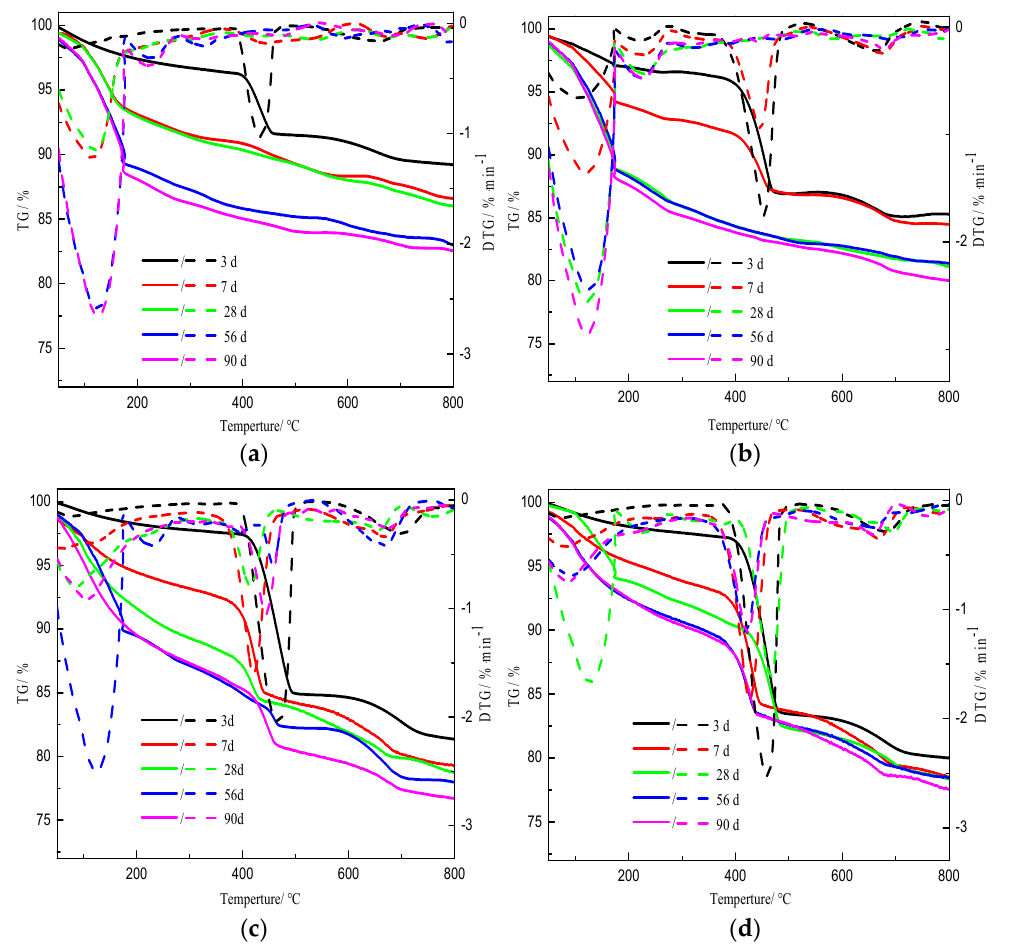
Figure 4. TG/DTG traces of samples: ( a ) initial C/S molar ratio 0.5; ( b ) initial C/S molar ratio 1.0; ( c ) initial C/S molar ratio 2.0; and ( d ) initial C/S molar ratio 2.5. The solid lines represent the TG results of the samples, while the dotted lines represent the corresponding DTG results.